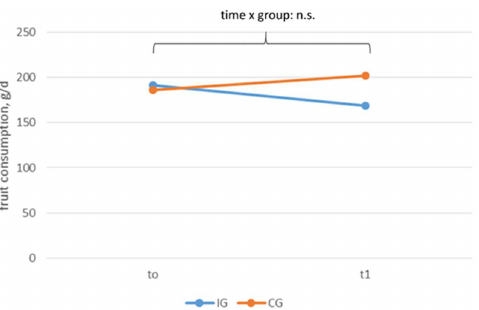
Figure 7. Fruit consumption according to time and group, n.s. p > 0.05.